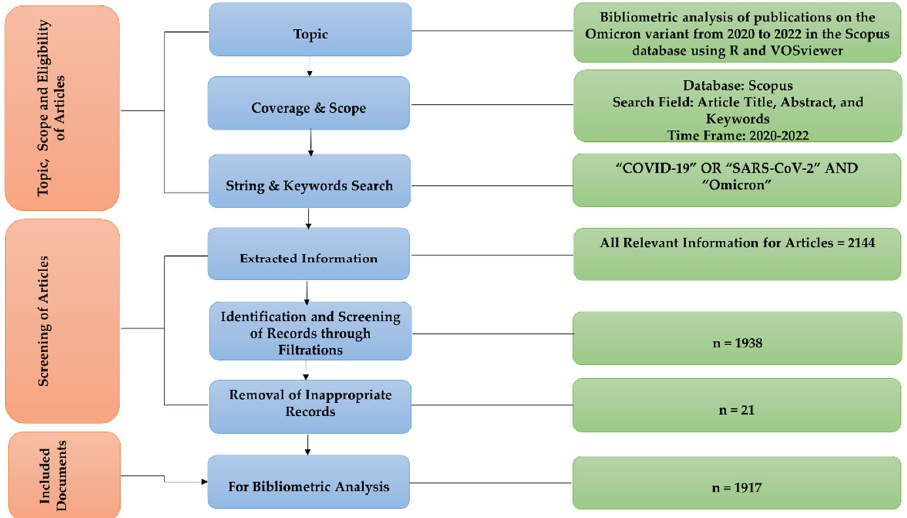
Figure 1. Flow chart of the search approach.